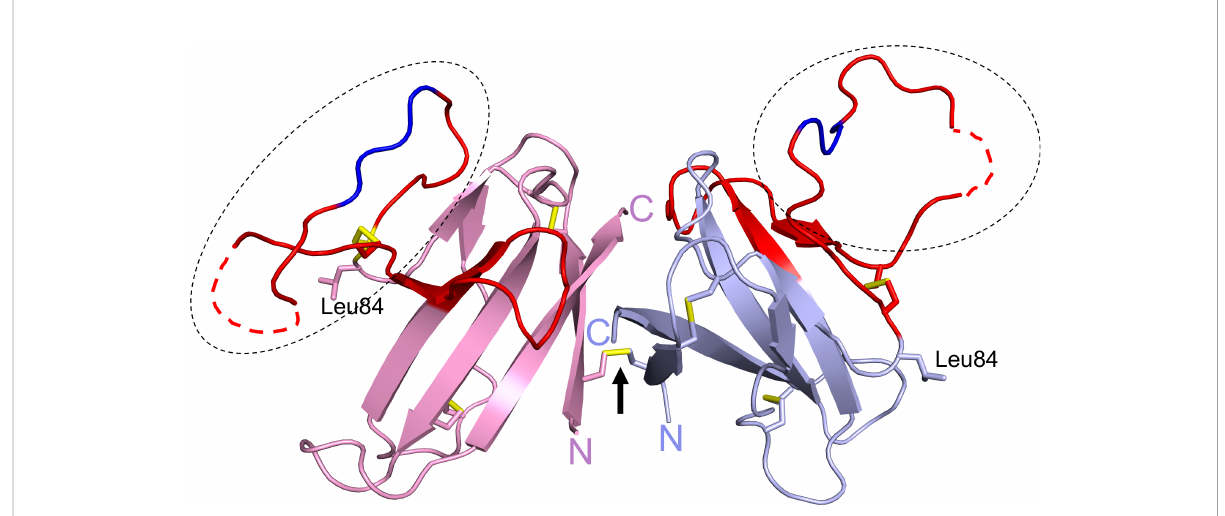
FIGURE 3 SARS-CoV-2 ORF8 structure. The structure of ORF8Leu84 (PDB code 7JTL) shows a homodimer formed by Cys20-Cys20 disul fi de bond (black arrow). Each ORF8 monomer (blue or pink) shows a Ig-like core with a SARS-CoV-2 unique sequence of 38 amino acid residues (red). A large loop (dashed ovals) extends out of the central core; the Y 73 IDI 76 motif (dark blue) and missing residues ~Glu64 to Ser69 (dashed red lines) are shown. Leu84 and the N- and C-termini are labelled. The three intramolecular and single intermolecular disul fi de bonds are shown in